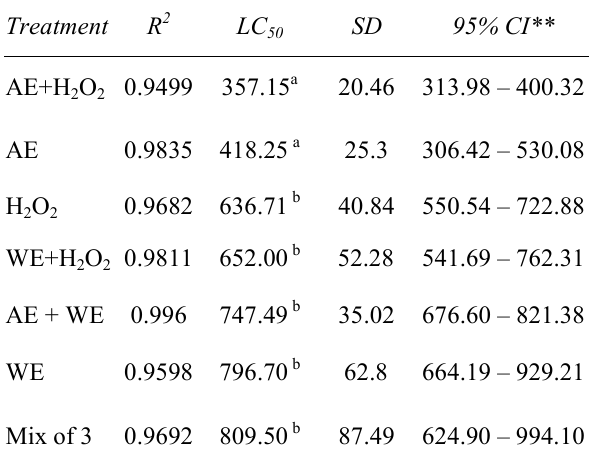
Table1: Linear regression analysis and toxicity index ; B g/ml) of N. sativa L. extracts hydrogen peroxide (LC 50 and combinations on MCF-7 breast cancer cells Treatment